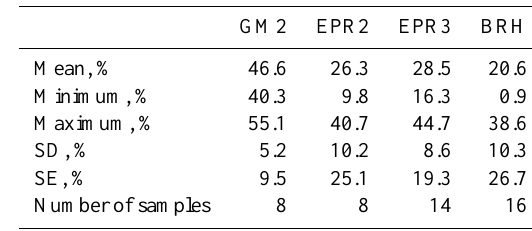
Table 3. Content of rock fragments by mass ( R m ) (>2mm) in the soil profile (0–9cm) for soils from the study